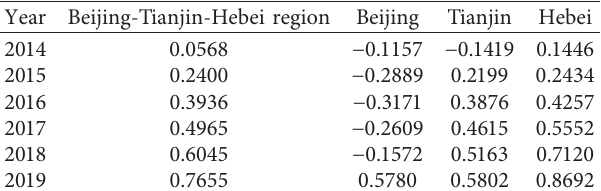
Table 5: The degree of coordination of the Beijing-Tianjin-Hebei complex system.